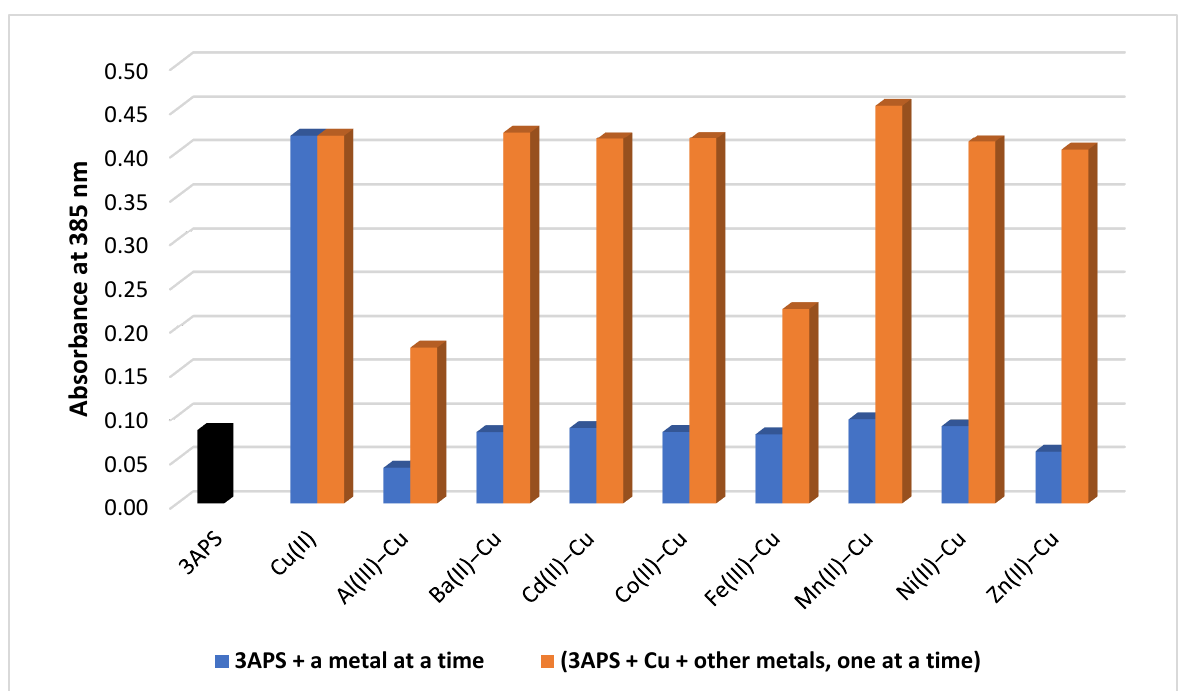
Figure 6. Absorbance interference of other metal ions with a 3APS – Cu(II) system measured at 385 nm. The blue color represents the absorbance of the mixture of 3APS with each metal ion individually, and the orange color represents the absorbance of the 3APS – Cu after the addition of each metal ion at a molar ratio of 1:2.